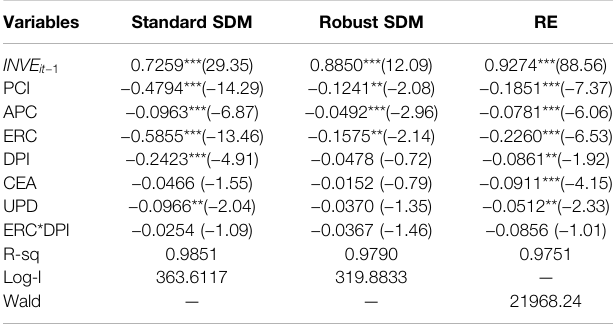
TABLE 12 | Robustness tests (INVE3).